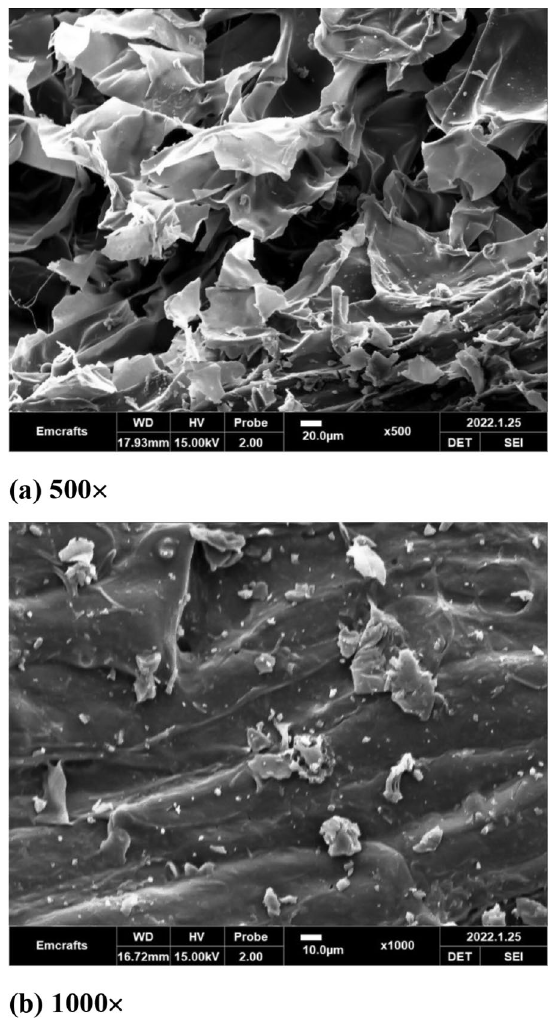
Fig. 3 SEM images of pine cone particles